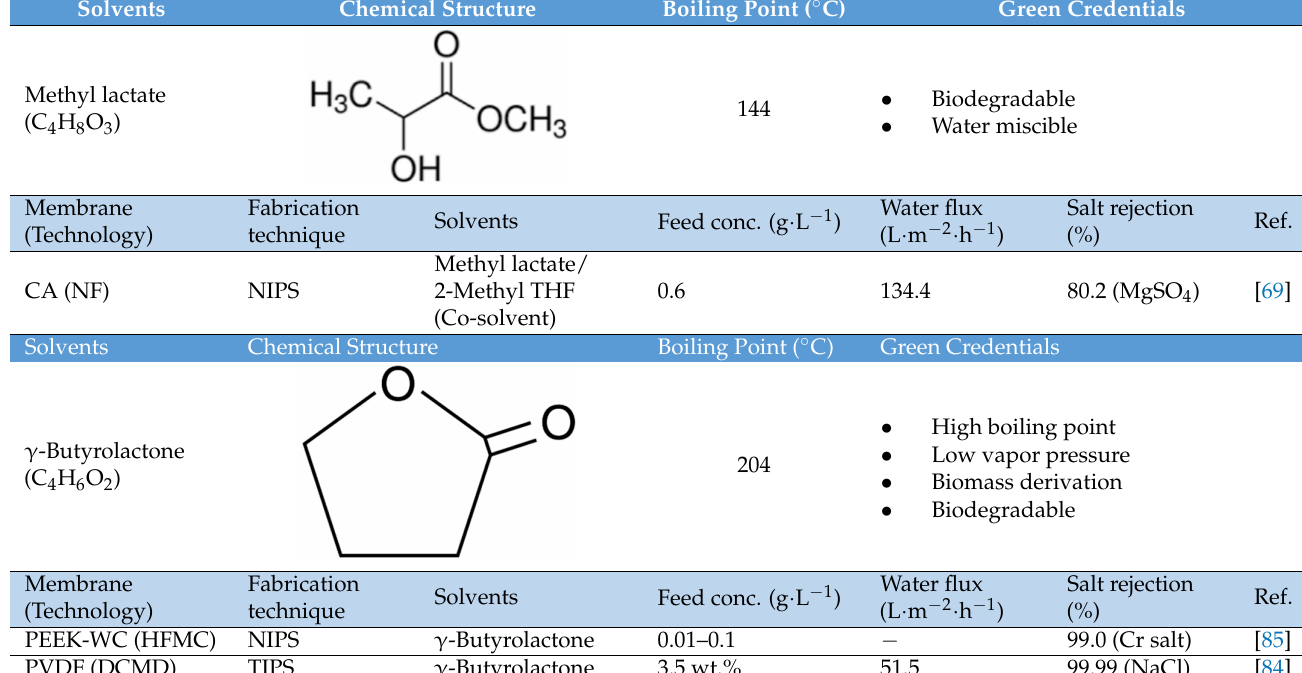
Table 4. The characteristics of synthetic organic solvents and their summarized studies in membrane desalination.